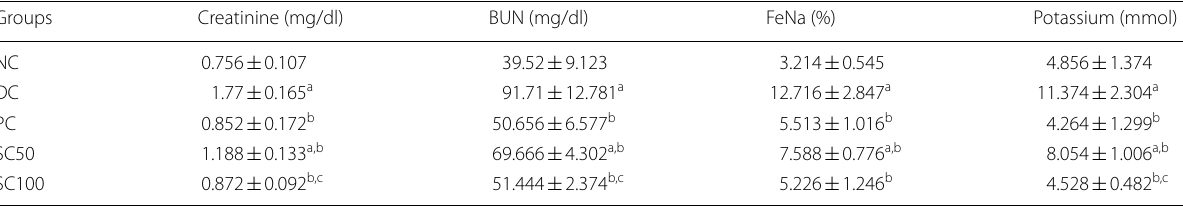
Data are expressed as mean S.D. (n 5). NC: normal healthy control; DC: diabetic control; PC: positive control (STZ induced diabetic rats treated with reference drug ± = acarbose (60 mg/kg body weight)); SC50 and SC100: STZ induced diabetic rats treated with S. commune extract (50 and 100 mg/kg body weight respectively) a P < 0.05 Different control groups when compared with normal group b P < 0.05 Diabetic control group when compared with other treated groups c P < 0.05 S. commune extract treated groups when compared with each other